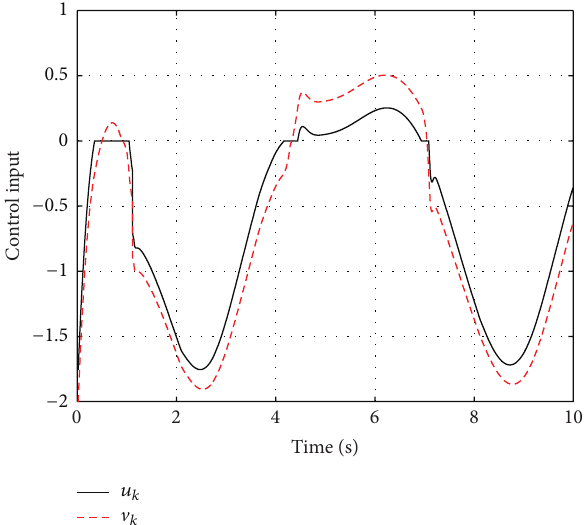
Figure 7: System output 𝑦 on 𝑦 𝑑 (𝑘 = 1) in Case